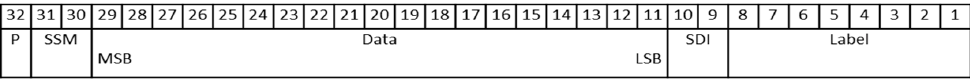
Figure 4. Rough architecture of a control computer.